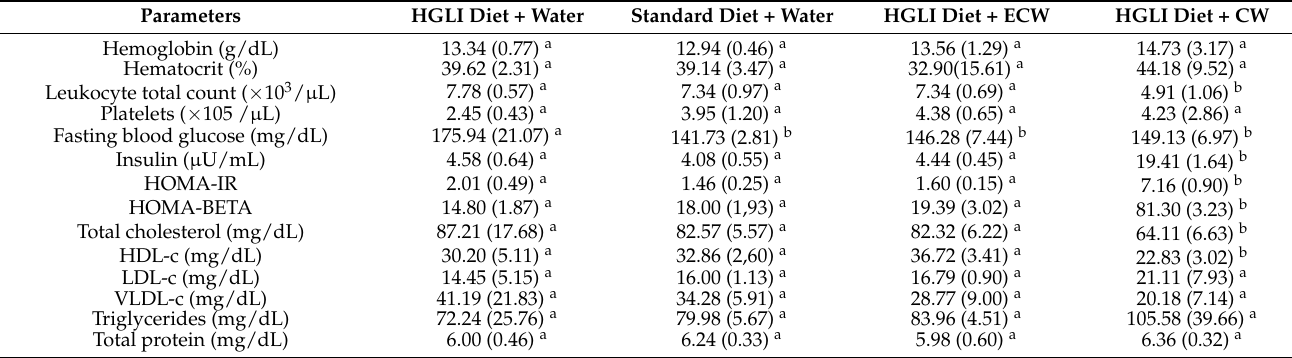
Table 1. Hematological parameters, fasting glucose, insulin, HOMA-IR, HOMA- β , lipid profile, assessing renal and liver function in adult male Wistar rats fed with the HGLI diet acclimated in the UnP/bioterium Brazil in January 2019.